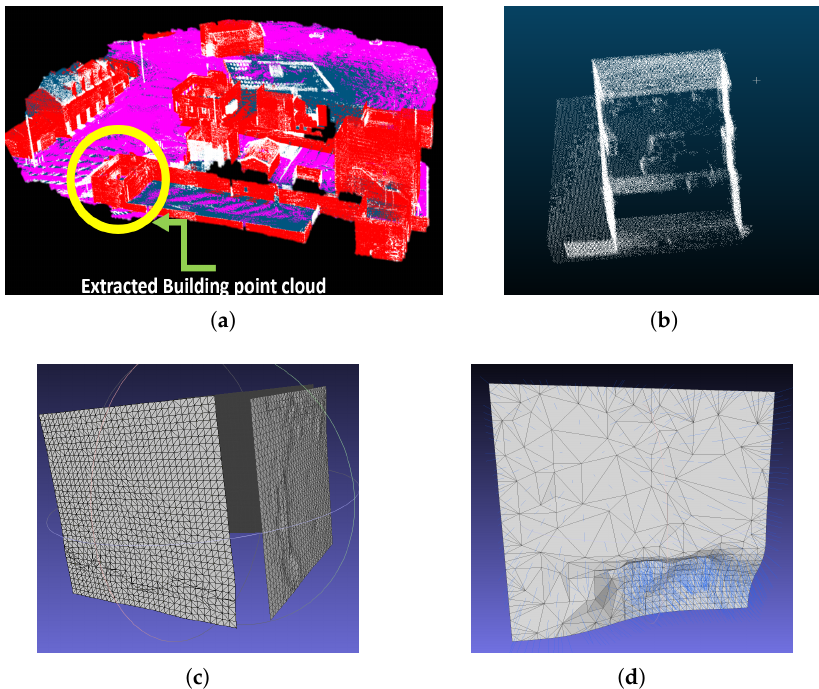
Figure 5. ( a ) FTIG Map showing extracted building point cloud. ( b ) 3D point cloud of building manually extracted from the FTIG point cloud. ( c ) Extracted planar features of builiding from FTIG. ( d ) Example of planar region that was automatically detected and that was simplified to reduce the number of